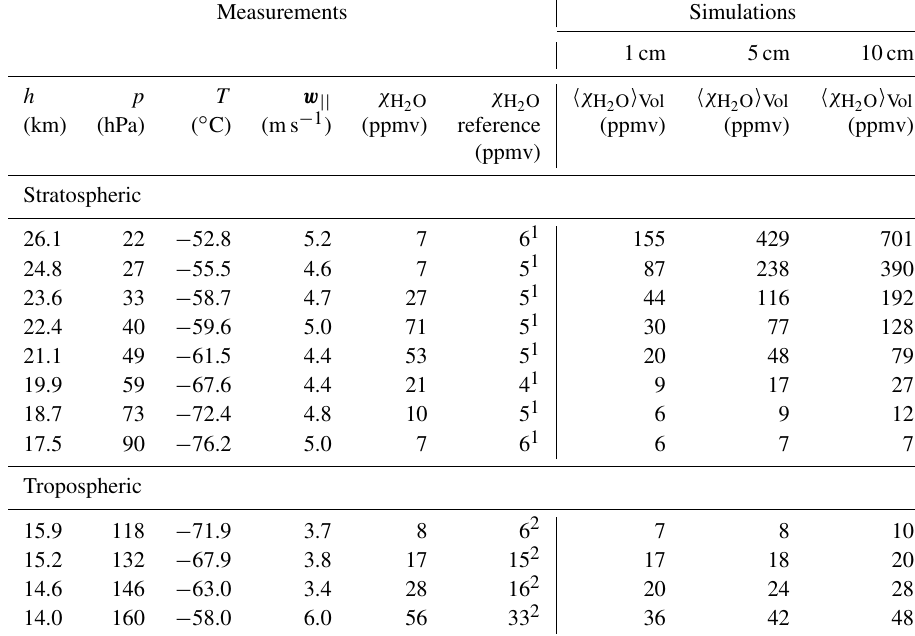
Figure 11. Collision/freezing efficiency of hydrometeors in the intake tube for the flight NT011 mixed-phase cloud with average vertical inlet velocity w || = 7.5ms − 1 . r liq = 100µm (red); r liq = 50µm (purple). (a–j) Freezing efficiency for various velocities ( v ⊥ ) perpendicular to the tube walls and impact angles β : (a) 1ms − 1 , 8 ◦ ; (b) 2ms − 1 , 15 ◦ ; (c) 3ms − 1 , 22 ◦ ; (d) 4ms − 1 , 28 ◦ ; (e) 5ms − 1 , 34 ◦ ; (f) 6ms − 1 , 39 ◦ ; (g) 7ms − 1 , 43 ◦ ; (h) 8ms − 1 , 47 ◦ ; (i) 9ms − 1 , 50 ◦ ; (j) 10ms − 1 , 53 ◦ . The “rest of the tube” takes account of all collisions occurring deeper than 5cm inside the tube, including the mirror holder. (k) Sum of the efficiencies from panels (a) – (j) weighted by the pdf of v ⊥ in Fig. 7a; behind each bar the thickness of the resulting ice layer is noted assuming a homogeneous ice cover inside the intake tube for the lower (left number) and upper (right number) LWC estimates for the cloud in NT011. Table 2. FLUENT stratospheric and upper tropospheric simulation input data and results for flight NT011. Measurements